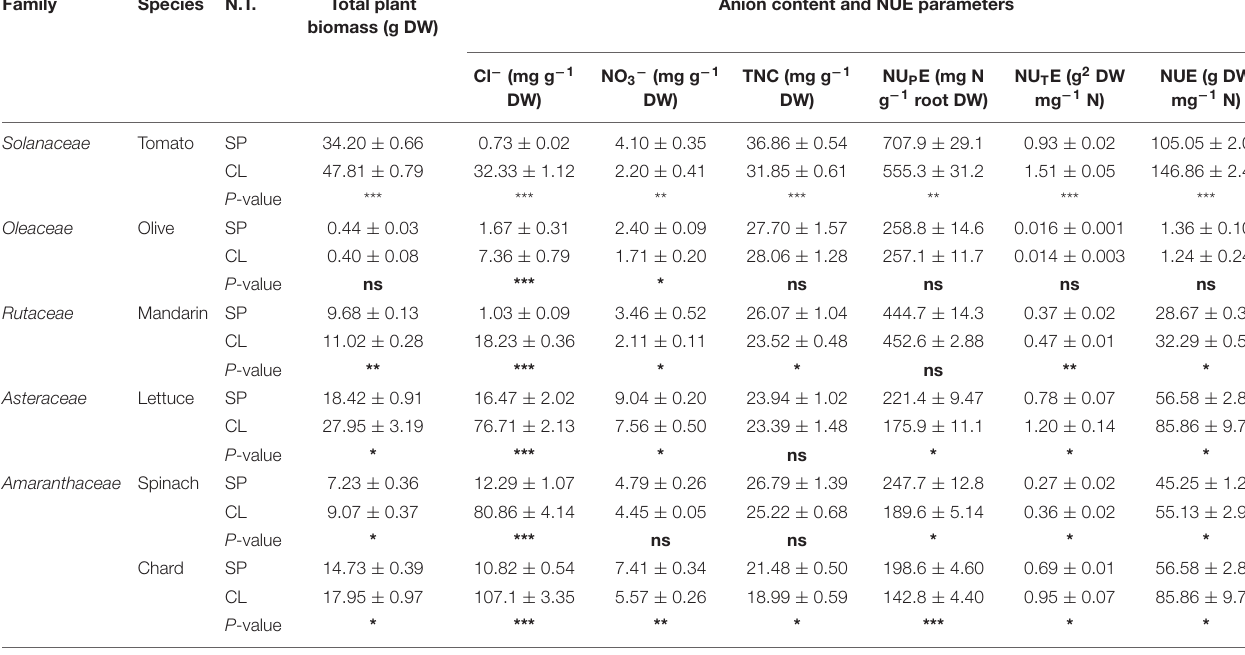
TABLE 1 | Effect of Cl − nutrition on biomass, anion content and NUE parameters in different species of agronomic interest. Family Species